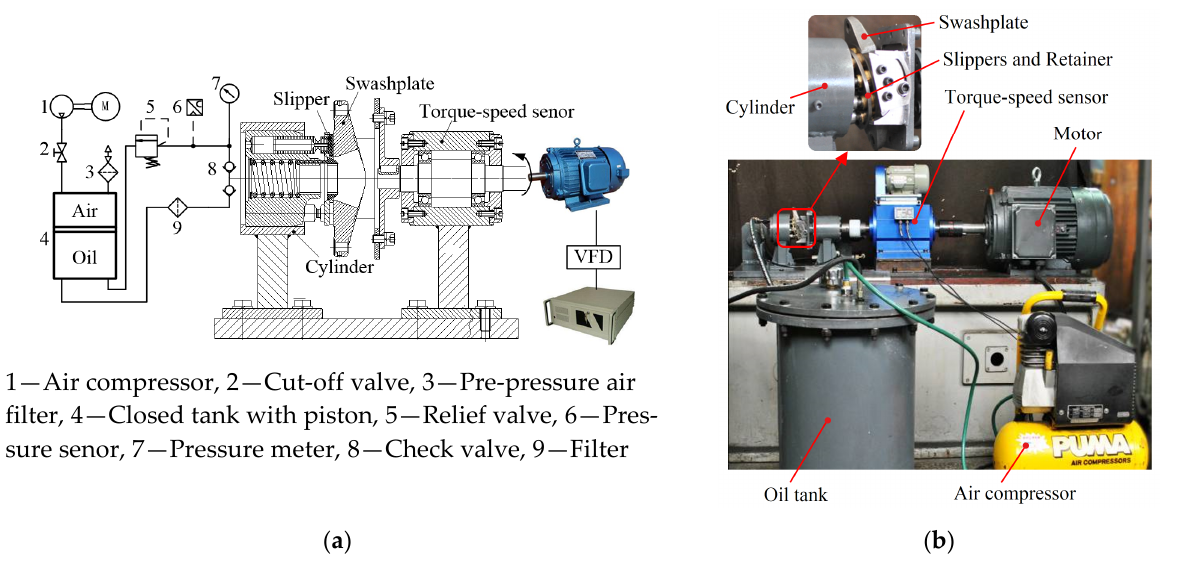
Figure 17. The friction power loss testing platform for the slipper/swashplate interface. ( a ) Schematic diagram. ( b ) Platform picture.